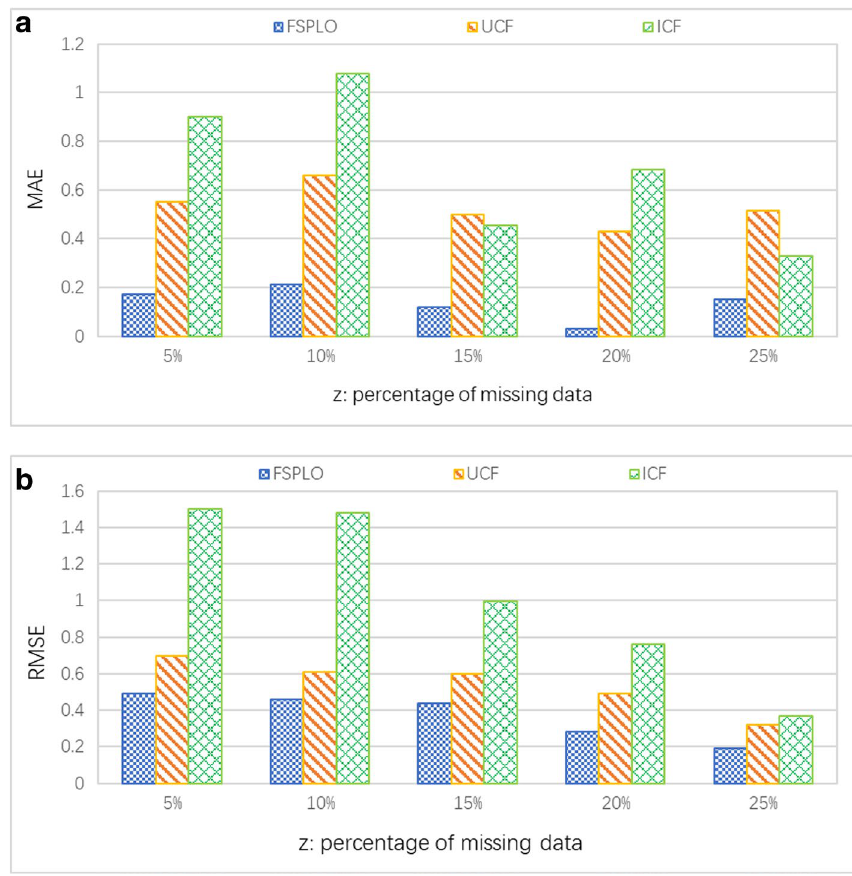
Fig. 3 Accuracy comparison of FSPLO, UCF and ICF